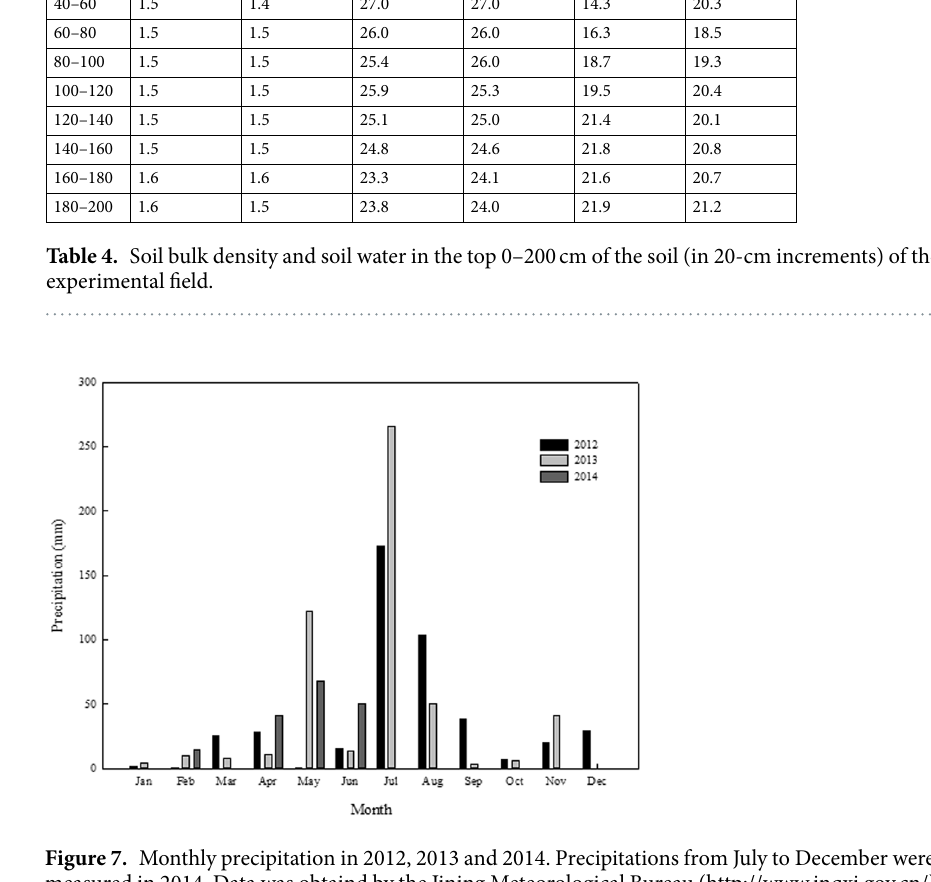
layers at specified depth were measured for SWC prior to SI: 0–20 cm (W2), 0–40 cm (W3), and 0–60 cm (W4). SI brought the mean SWC in each measured soil layers to 65% FC at jointing (Z31, first node detectable) and 70% of FC at anthesis (Z61, beginning of anthesis) 43 .